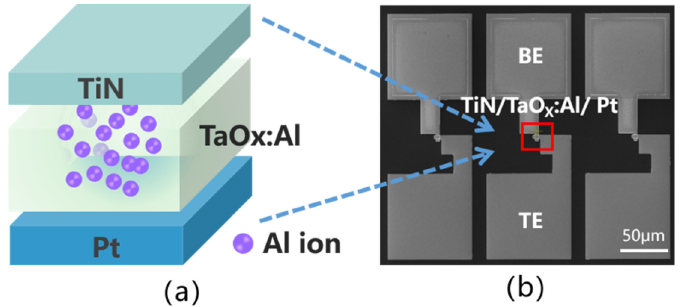
Figure 1. ( a ) The structure diagram of Pt/TaO x :Al/TiN RRAM; ( b ) SEM image of TaO x -based RRAM with Al ion local doping.